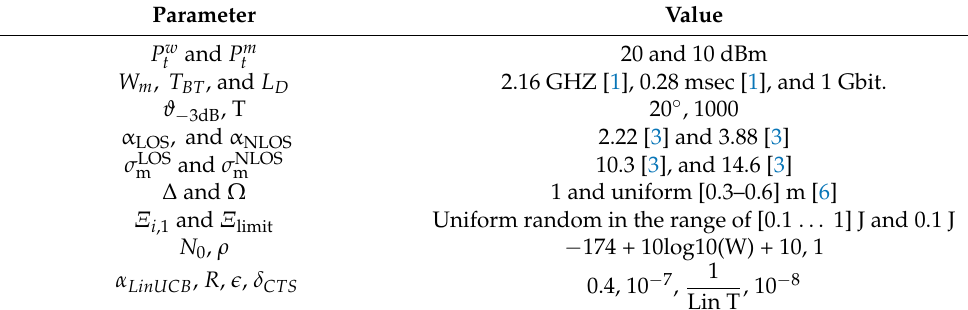
Table 1. Simulation Parameters.